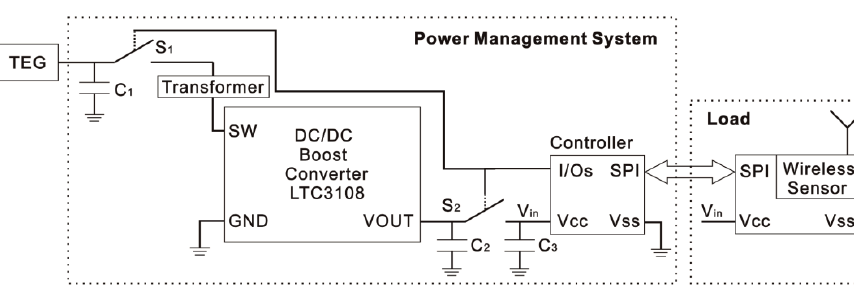
Figure 4. Schematic diagram of power management system.